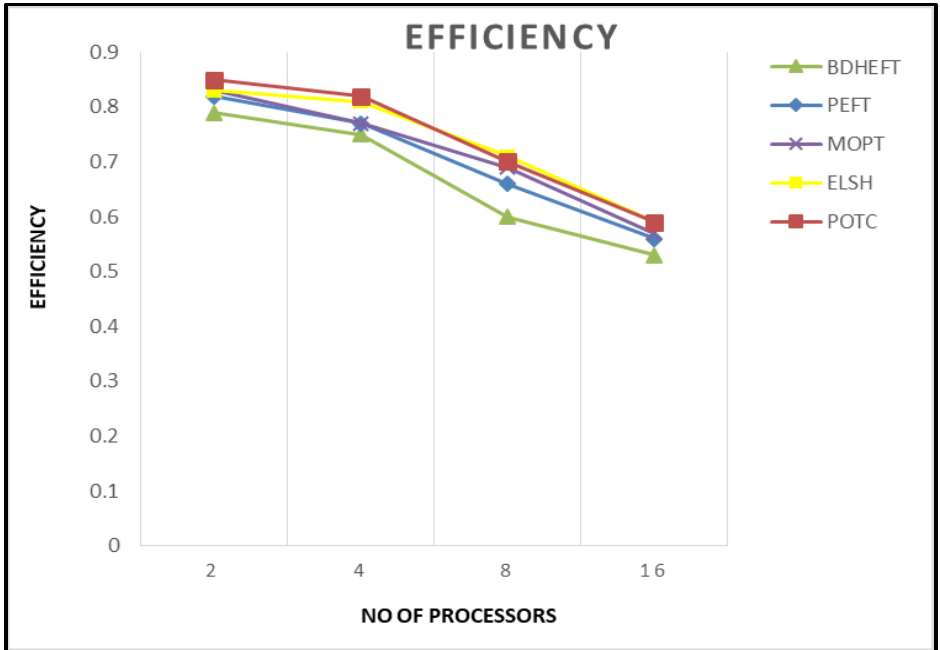
Figure 7. Efficiency comparisons of the four algorithms.